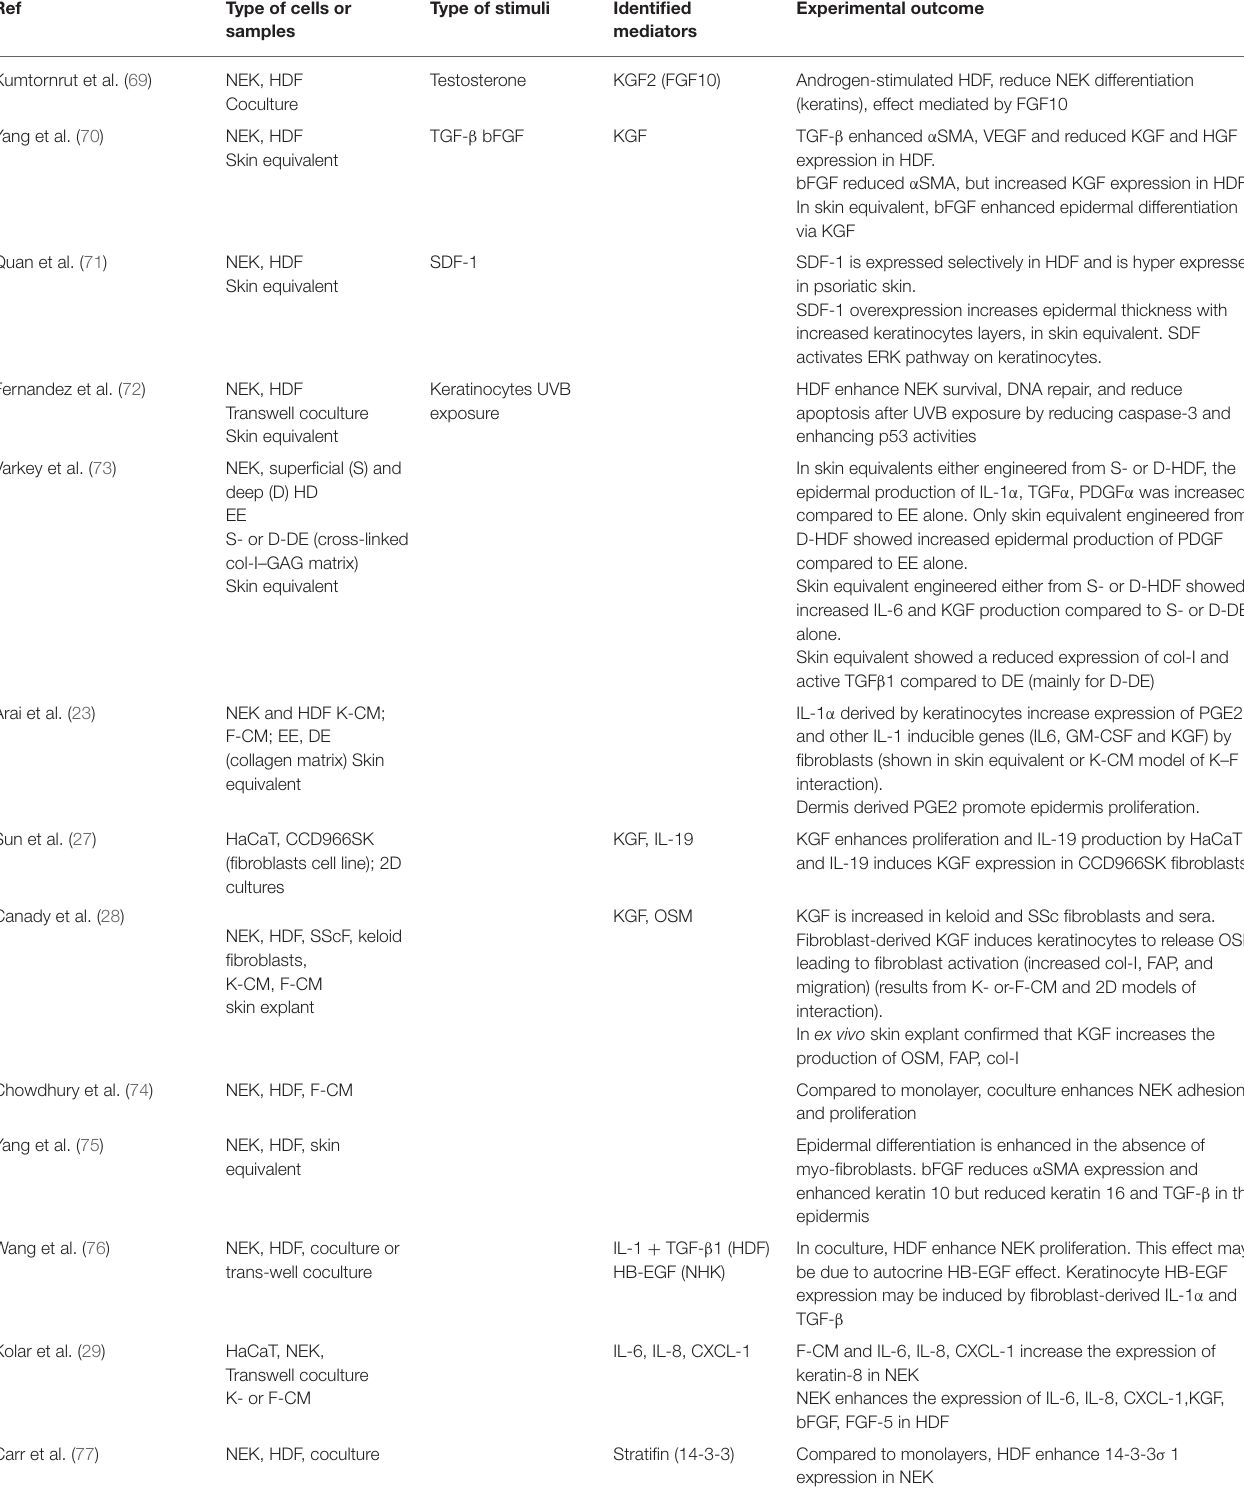
TABLE 2 | In vitro and ex vivo studies on the effect of human dermal fibroblasts on